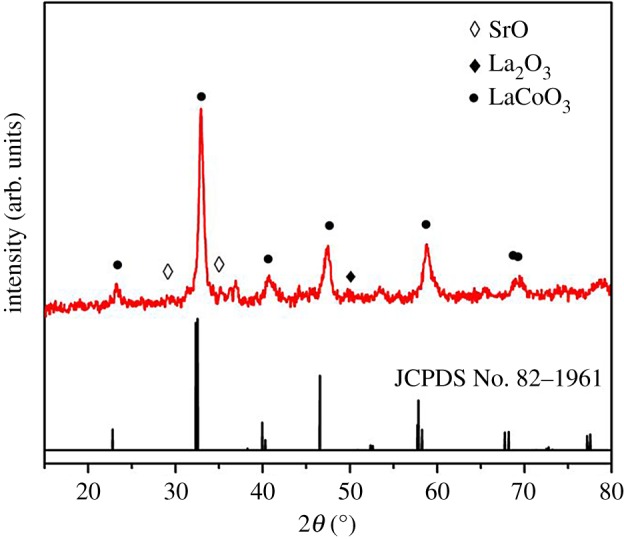
XRD patterns of the La0.6Sr0.4CoO3 perovskite catalyst.